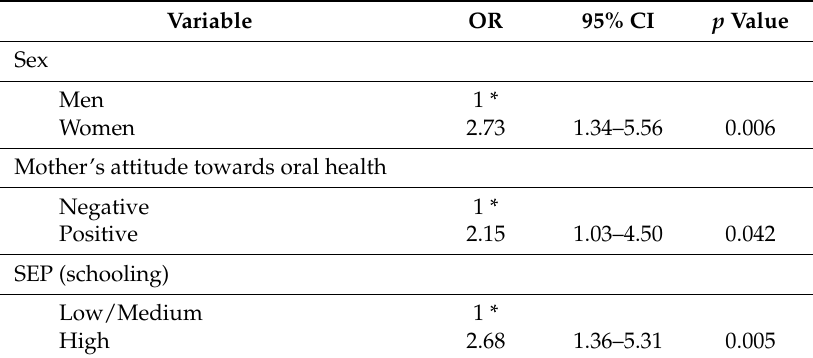
Table 3. Multivariate logistic regression model for visits to the dentist in the last year by Nicaraguan schoolchildren to receive professionally applied topical